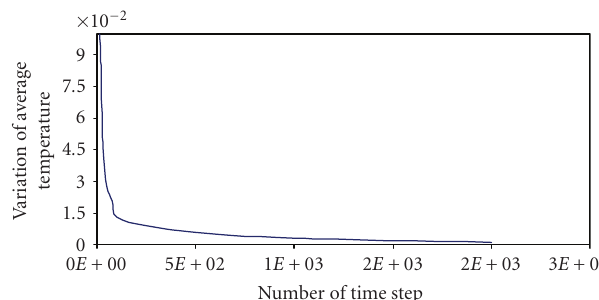
Figure 13: Temporal convergence analysis for the carbon-braided RUC as orthotropic material.